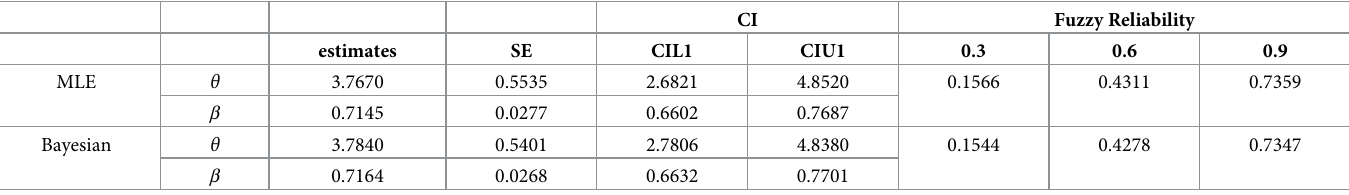
Table 6. MLE and Bayesian for parameter estimates of MKTL distribution for the data under investigation.